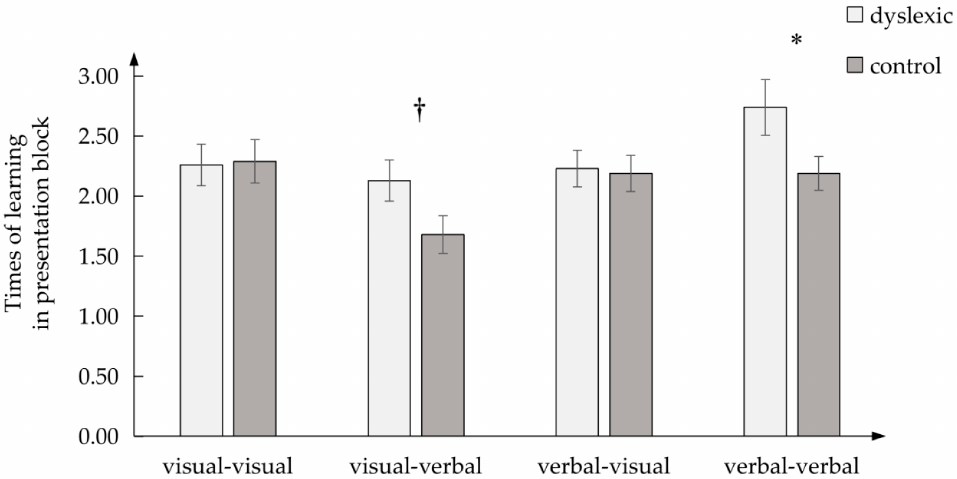
Figure 3. The early learning effect in four PAL conditions between dyslexic and control groups; * p < 0.05; 0.05 < p < 0.10.